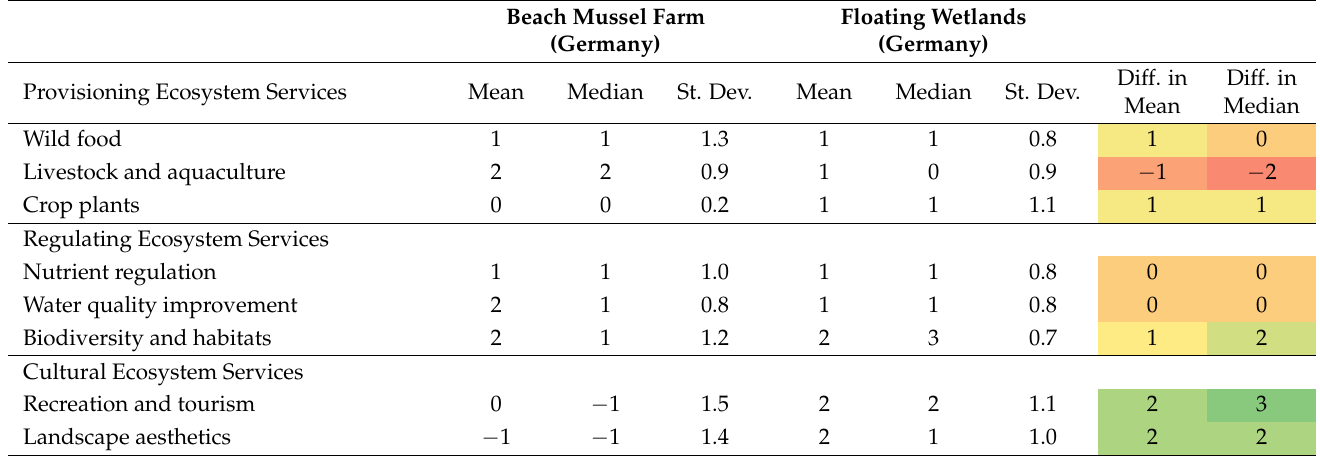
Table 8. Comparison of a mussel farm application and floating wetland, assessing the impacts on ecosystem services. The mussel farm applications were a beach mussel farm and floating wetland, both located in Greifswalder Bodden. The assessment was conducted by local non-expert stakeholders. The mean and median values were calculated based on the aggregated number of